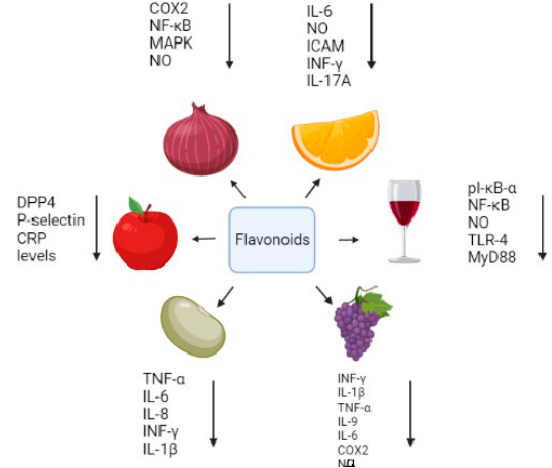
Figure 3. Different flavonoids and their function.